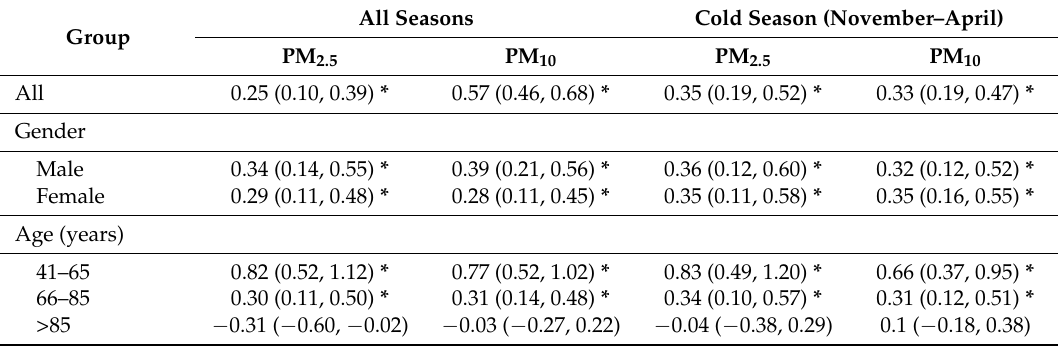
Table 3. Percentage increase in IHD hospitalizations (95% CI) associated with a 10 μ g/m 3 increase in PM 2.5 and PM 10 concentrations at lag 0 by gender and age groups.